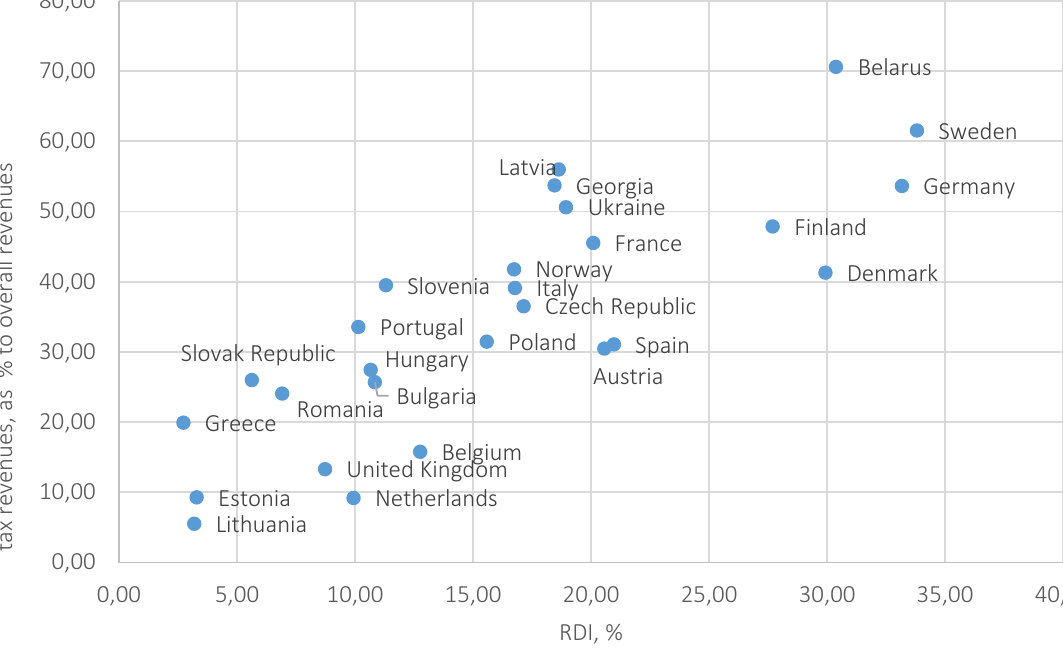
Figure 1. Revenue decentralization in selected countries over 1992–2017 period